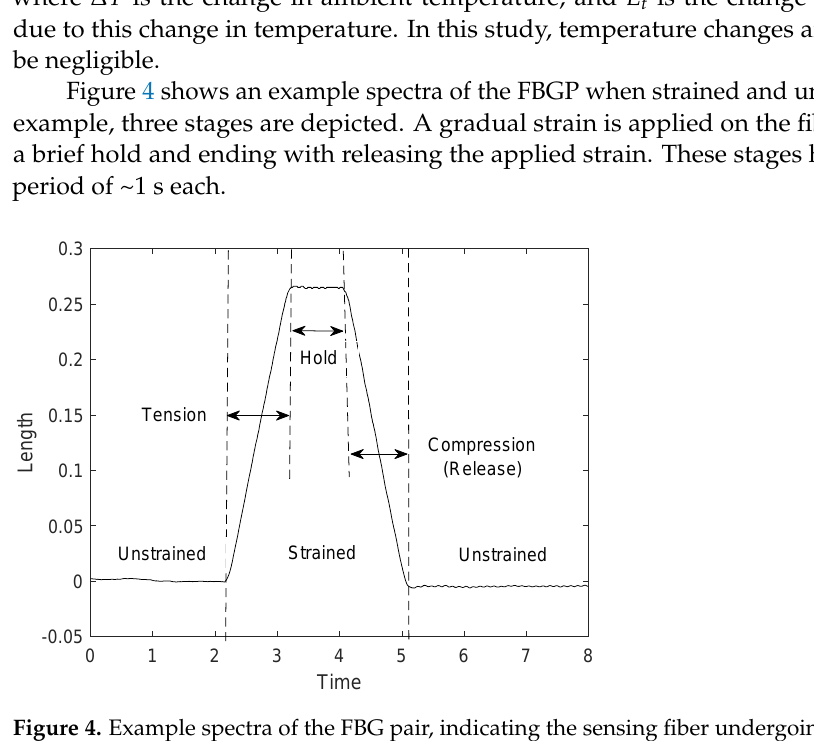
Figure 4. Example spectra of the FBG pair, indicating the sensing fiber undergoing gradual tension and